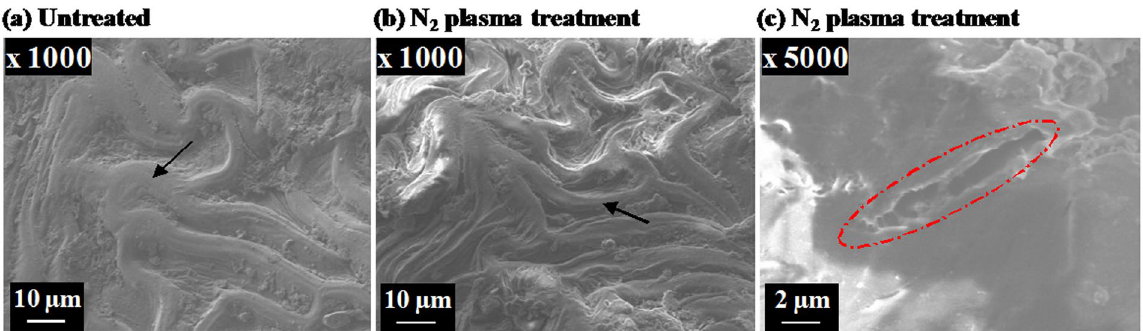
Figure 6. Representative SEM images of the surfaces of ( a ) untreated cotton seeds and ( b , c ) cotton seeds treated for 27 min with N 2 plasma. Treatment of seeds with N 2 plasma resulted in thinning of the ridges and the presence of a larger number of thin grooves, which was labeled by arrows. In addition, cracks of width around 2 µ m could be observed in red mark